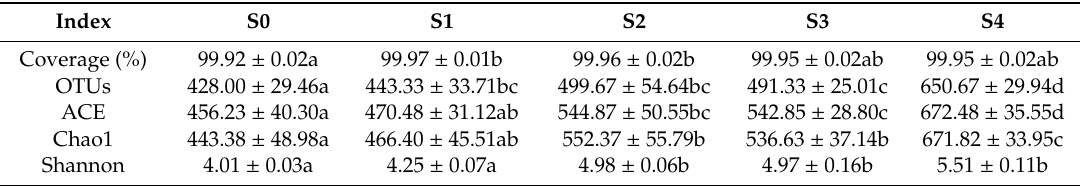
Table 4. OTUs and alpha-diversity of bacteria.